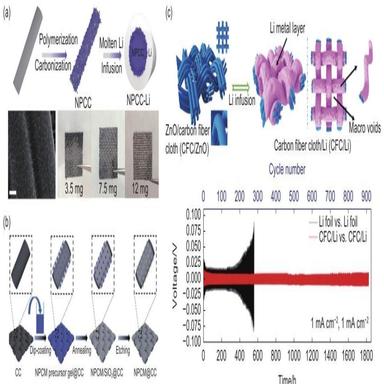
a) Fabrication process, SEM image, and photographs of the NPCC-Li electrode. Reproduced by permission of Wiley-VCH. (b) Preparation process of the NPCM@CC. Reproduced by permission of the Royal Society of Chemistry. (c) Synthetic process and cyclic